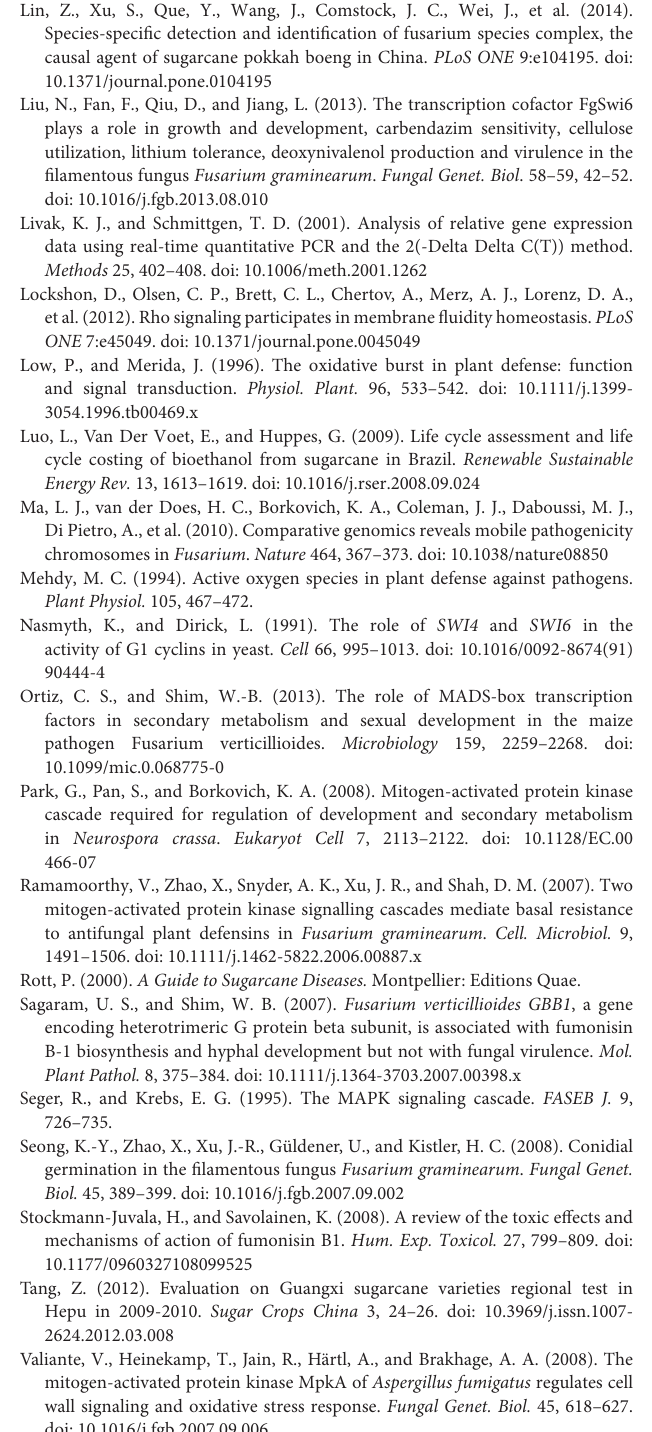
Supplementary Image 8 | Disease symptom of sugarcane stems infected with 10 6 conidia of WT, 1 Fvbck1, FvBck1-C, CAT-OE6, and POX-OE13 strains for 7 days. Bar = 1cm. Supplementary Table S1 | PCR primers used in this